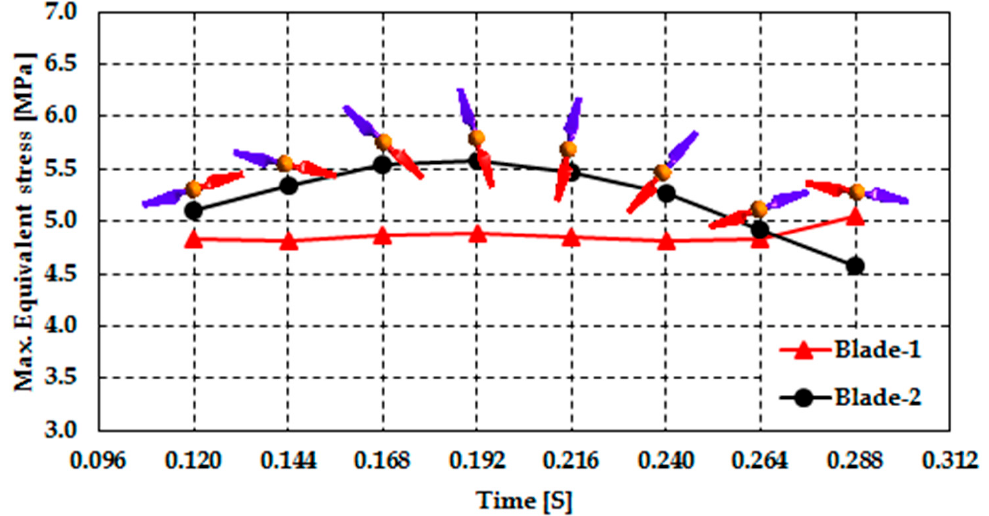
Figure 9. Variation of stress and deformation at rotating turbine blades for profiled flow.